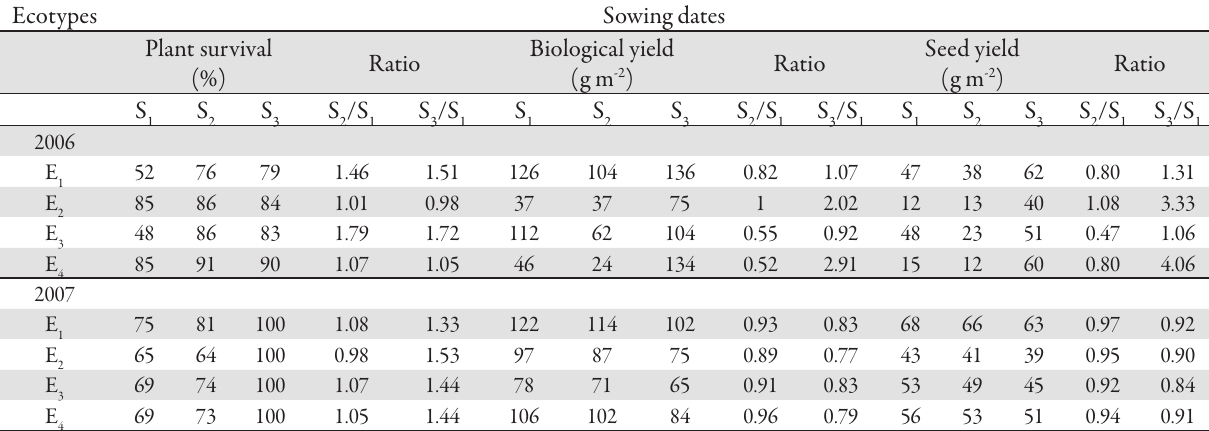
Tab. 4. Interactive effects of sowing dates and different ecotypes of cumin ( Cuminum cyminum L.) plant survival, biological, and seed yield in 2008 and 2009